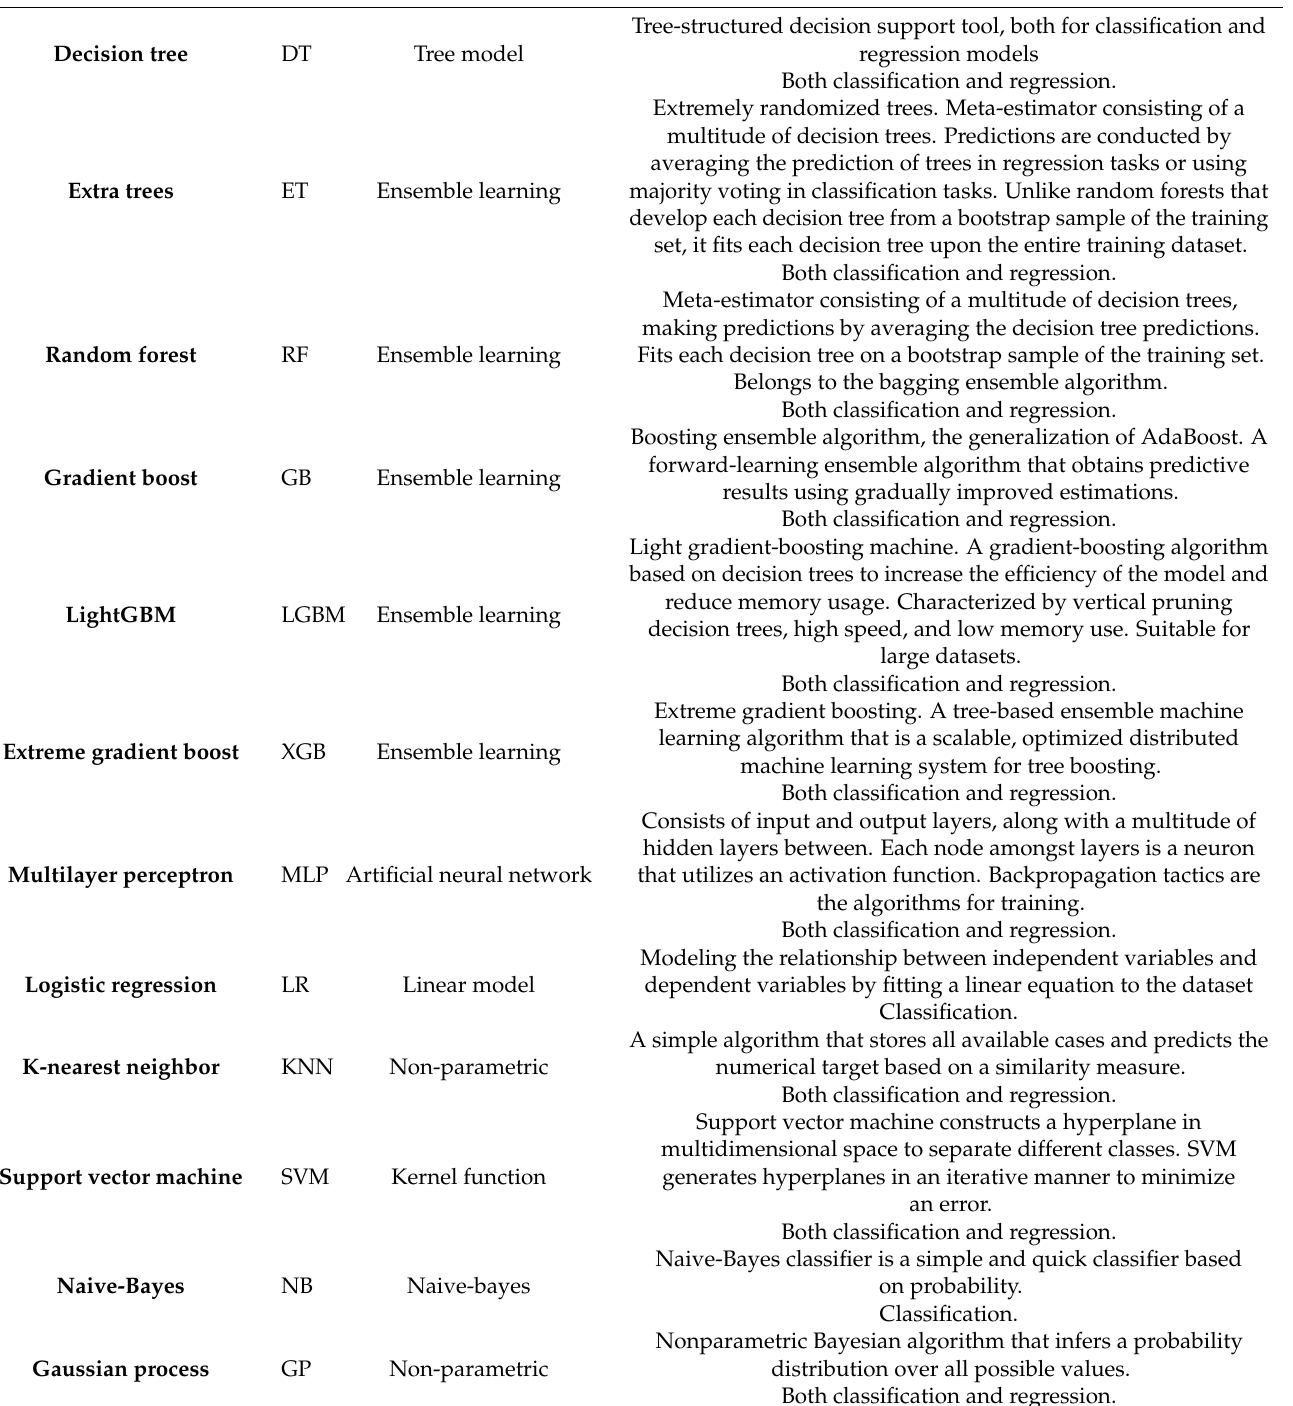
Table 7. Machine learning algorithms for